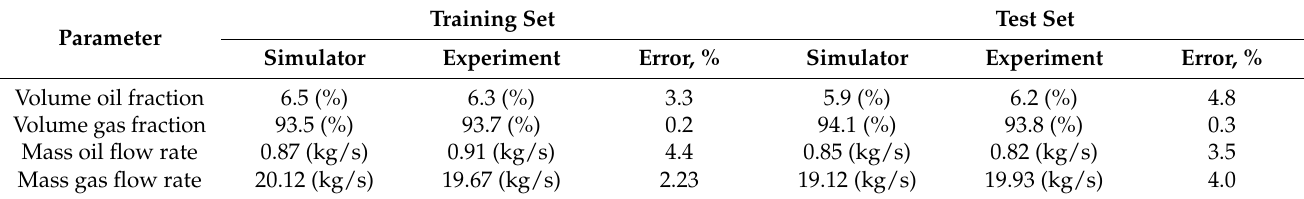
Table 5. Comparison of the target parameters on the training and test